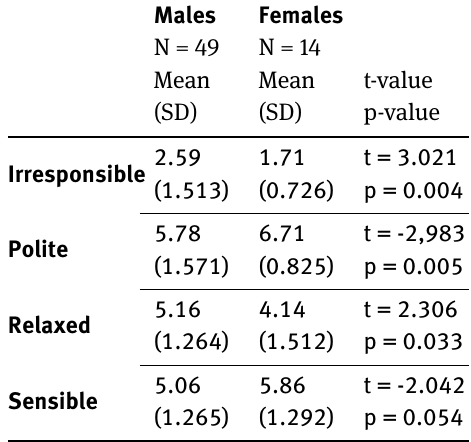
Table 7: Statistical comparison of robot evaluations by gender Males